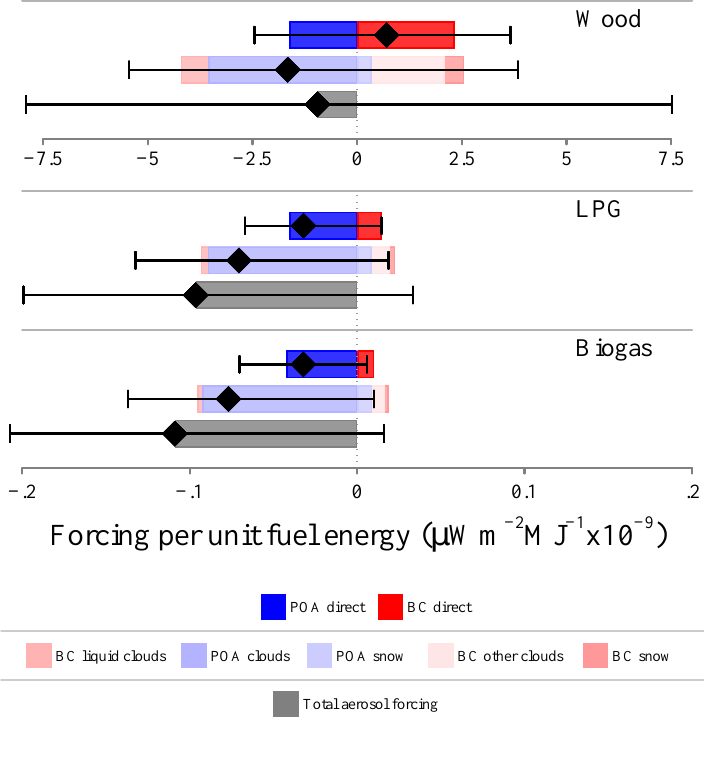
Figure 6. Forcing per unit fuel energy for wood, biogas, and LPG stoves due to EC and OC aerosols. For each fuel, direct forcing due to BC (EC), and POA (OC*1.9) are the bold, top bars. The middle stacked bars shown the forcing due to indirect effects and the bottom, grey bar shows the total forcing due to BC and POA aerosols. Note that wood is on a different scale compared to LPG and